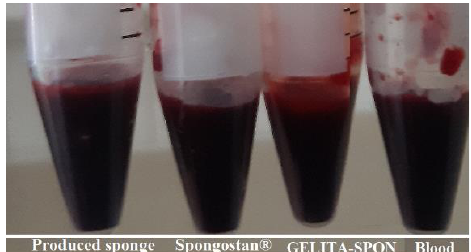
Figure 8. The results for CT coagulation